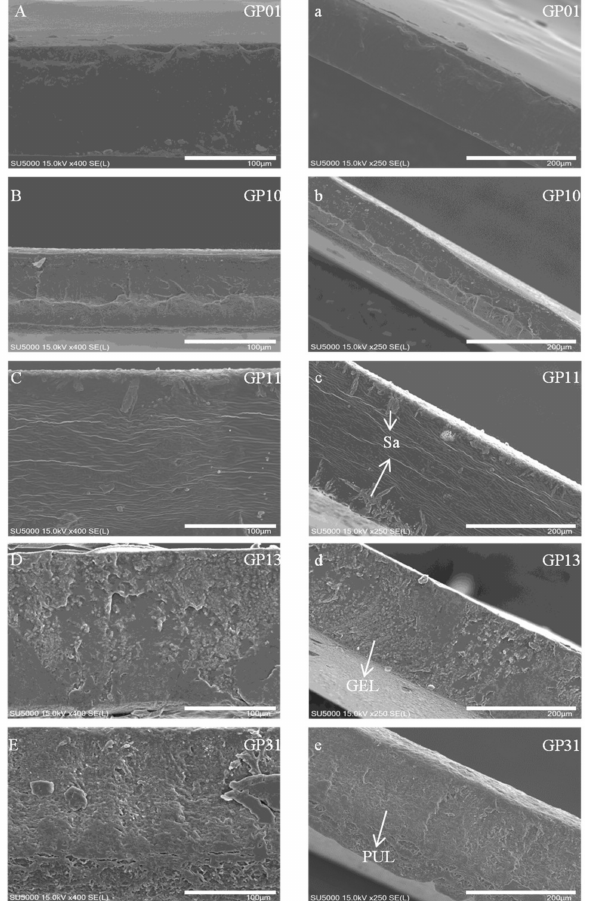
Figure 2. SEM images of the cross-sectional microstructure of different films. ( a – e ) are 250 × magnifi- cation, and ( A – E ) are 400 × magnification (PUL: Pullulan, GEL: Gelatin, Sa: Sodium alginate).